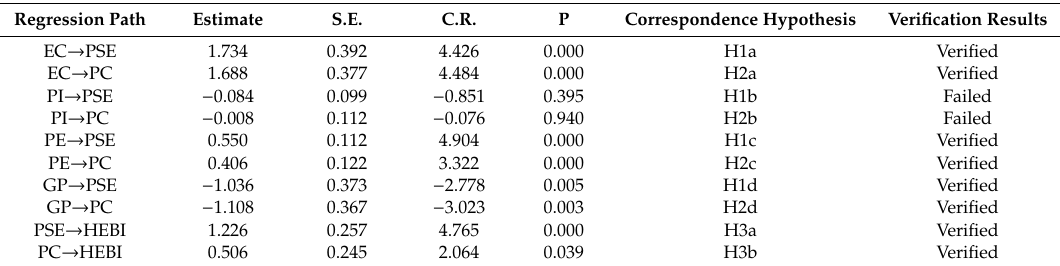
Table 5. Revised model path / load analysis